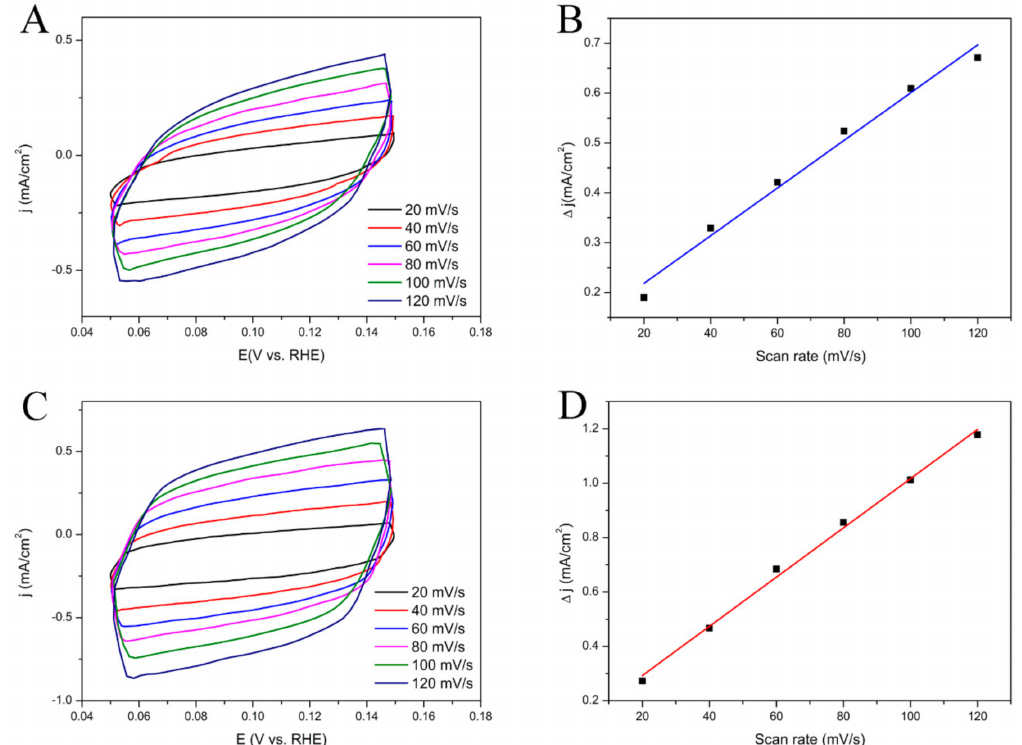
Figure 3. ( A ) CV curves of ( A ) rGO-100NS and ( C ) rGO-NS-Ni with different scan rates from 20 to 120 mV/s in the range of 0.05–0.15 V in 0.6 M KOH. Scan rate dependence of the current densities of ( B ) rGO-100NS and ( D )